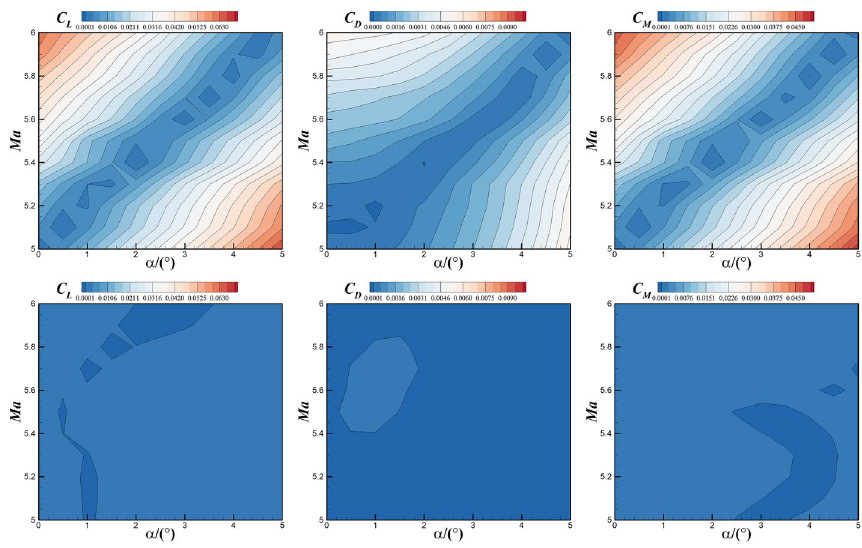
Fig. 24 Comparison of absolute error contours of C L (left), C D (middle), and C M (right) for MLP and CNN predictions